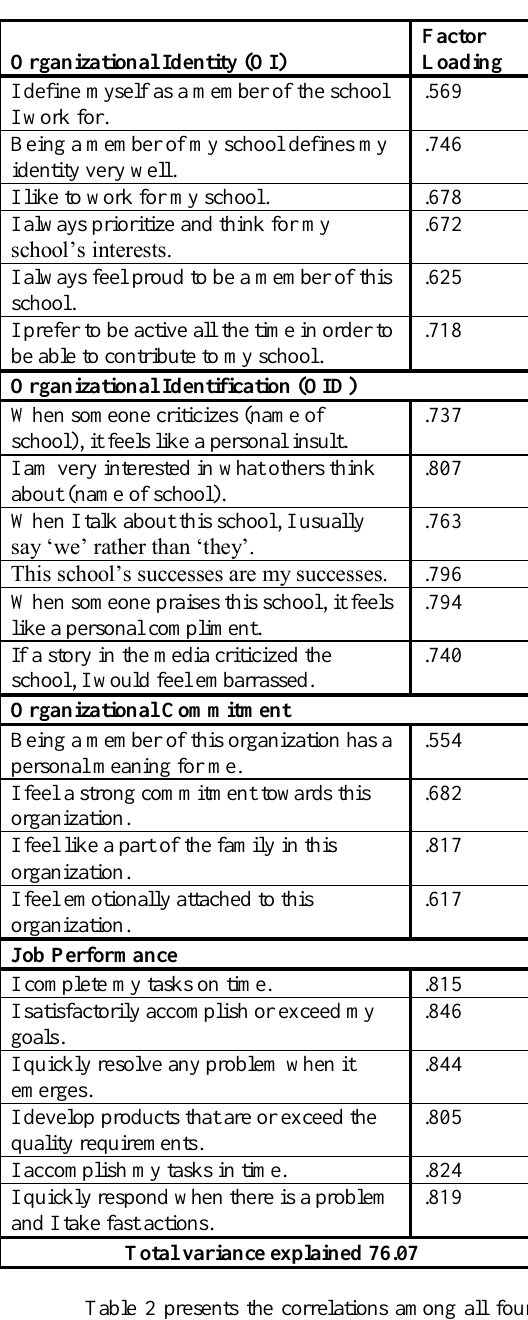
Table 1: Results of the Exploratory Factor Analysis